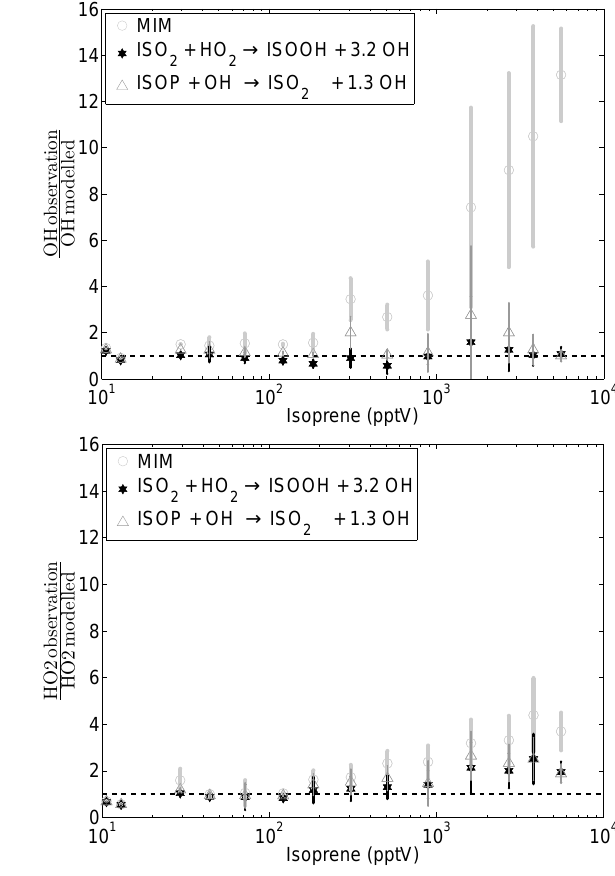
Fig. 16. Ratio of observed and modelled OH and HO 2 concentrations as a function of isoprene and other conditions observed simultaneously with isoprene.